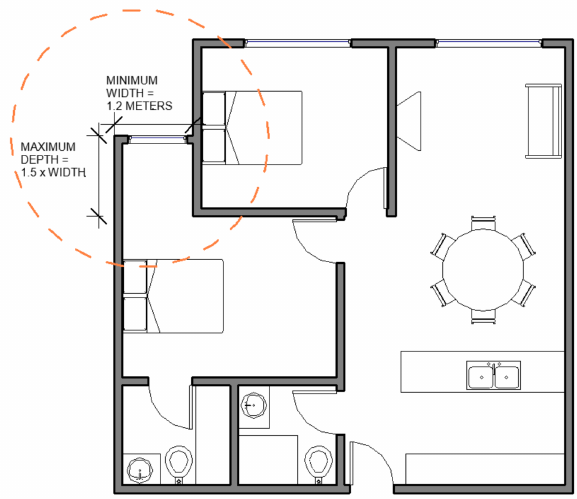
Figure 2. Plan showing the snorkel design window as per Victoria Planning Provision Amendment